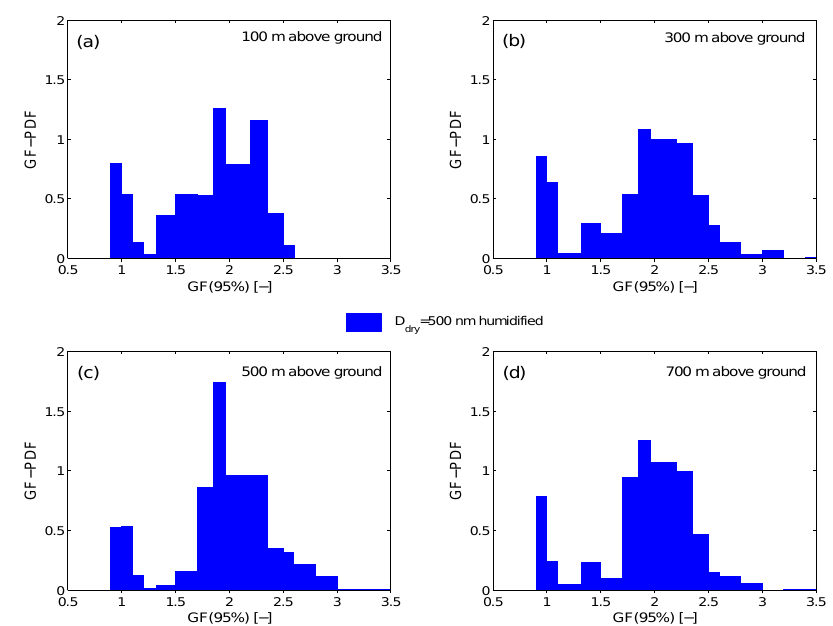
Figure 11. GF-PDFs recorded near Cabauw on 24 May 2012 at four different altitudes: approximately 100, 300, 500 and 700ma . g . l . seen in panels (a–d) , respectively. Every curve is the mean over the two flown profiles NHP1 and NHP2.